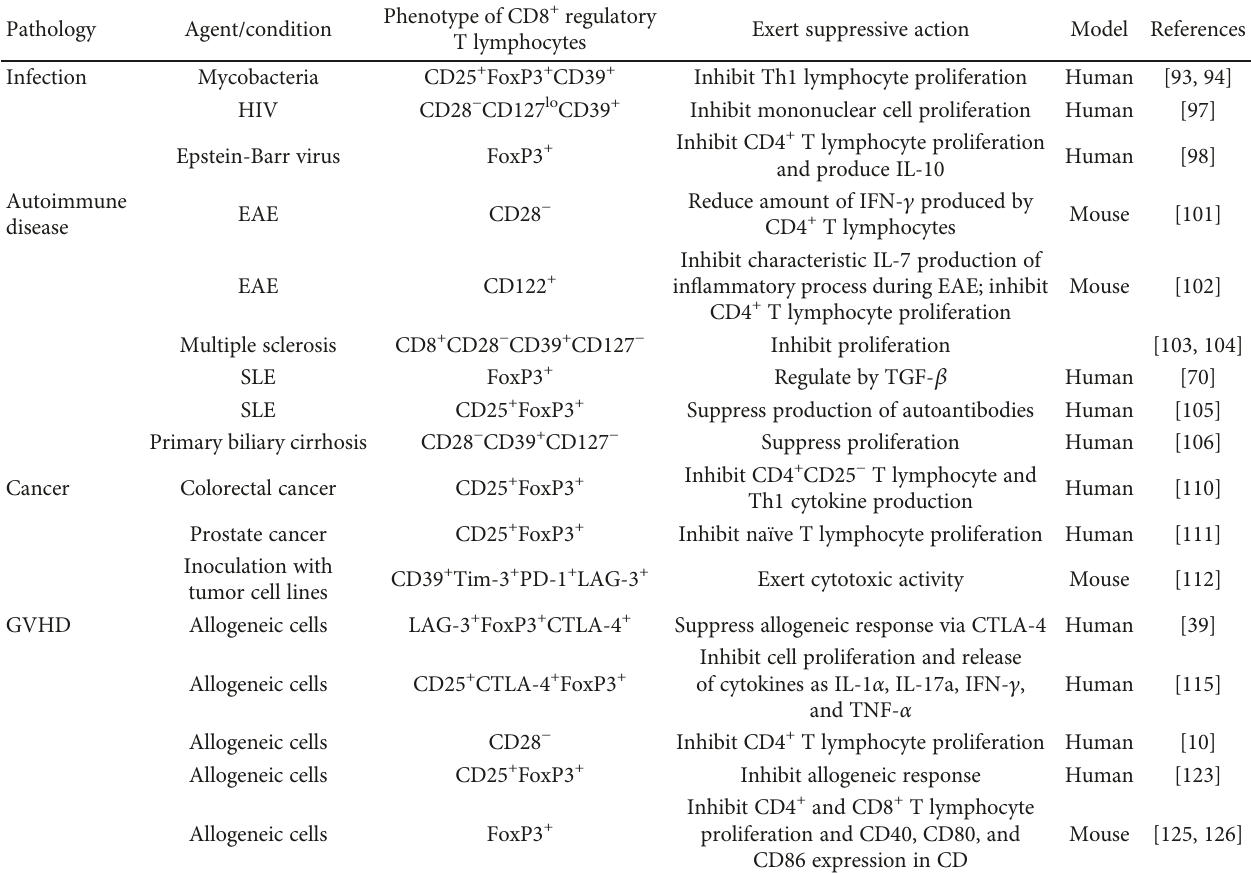
Table 1: Phenotypes of CD8 + Treg lymphocyte populations and their role in di ff erent pathologies.